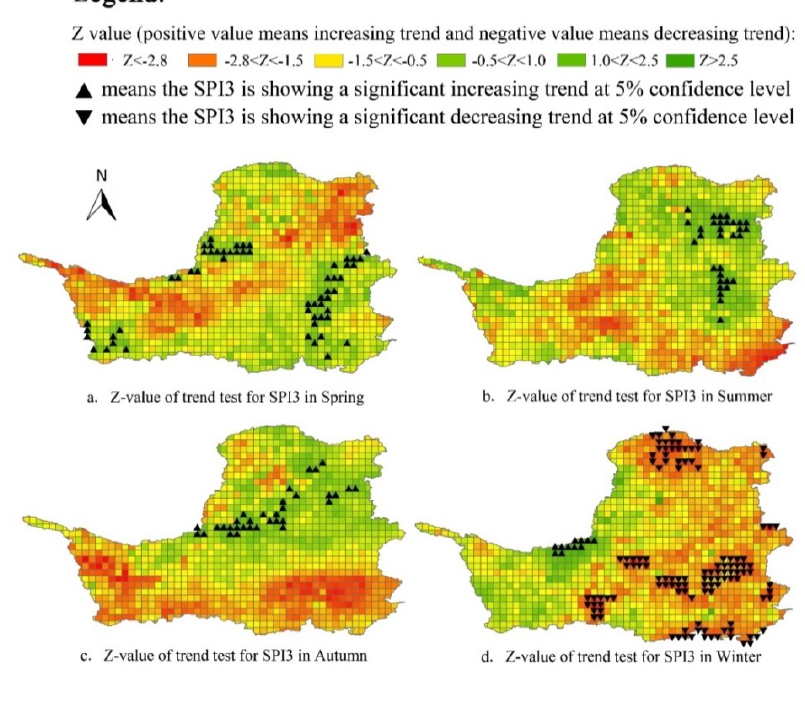
Figure 9. The changing trend of drought in the four seasons of the Loess Plateau.